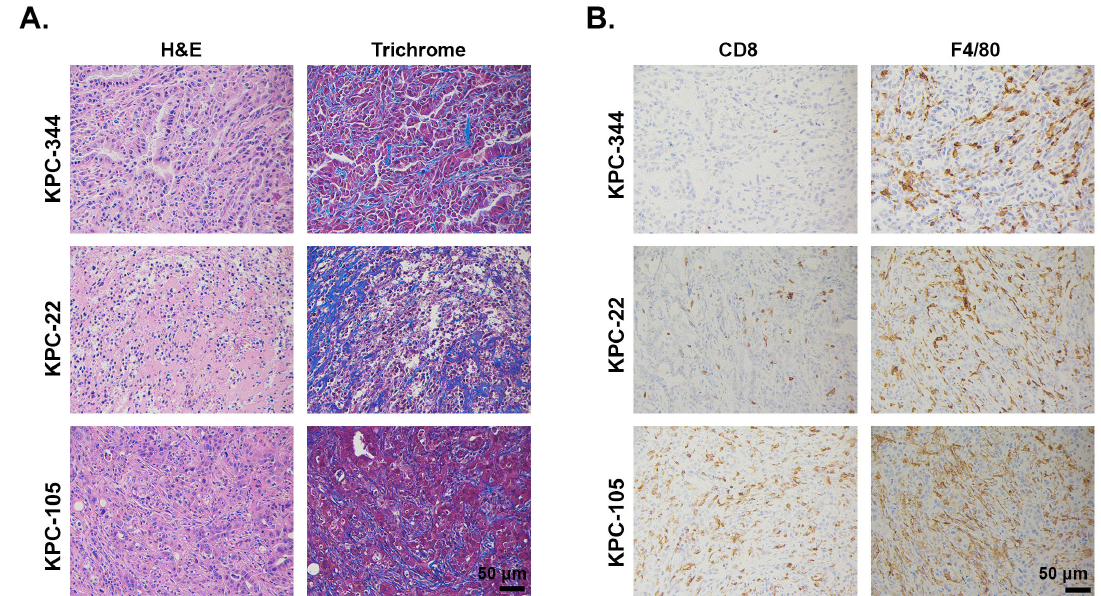
Figure 3. Desmoplasia, CD8 + T cells, and macrophage infiltration in mouse implantable KPC tumors. KPC cell lines (KPC-344, KPC-22, KPC-105) established from KPC spontaneous mouse model were injected subcutaneously in C57BL/6J mice. The tumors were H&E or trichrome stained ( A ) or stained by immunohistochemistry for CD8 + T cells and the macrophage marker F4/80 ( B ). Antibodies used: CD8 (Cell Signaling, #98941) and F4/80 (Cell Signaling, #70076). Magnification, 20×.